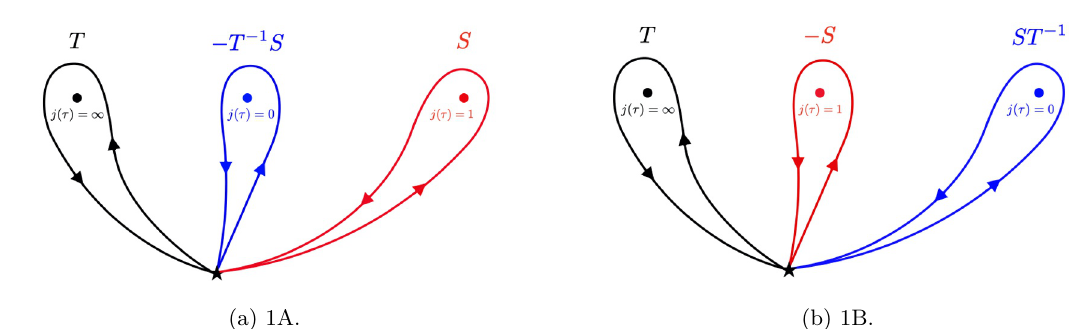
Figure 1. These figures illustrate the 1A (left) and 1B (right) building blocks by showing the relative positions of the three strings associated to the points τ = i ∞ , i, ρ in moduli space. In addition the respective monodromy action when encircling the strings counterclockwise is